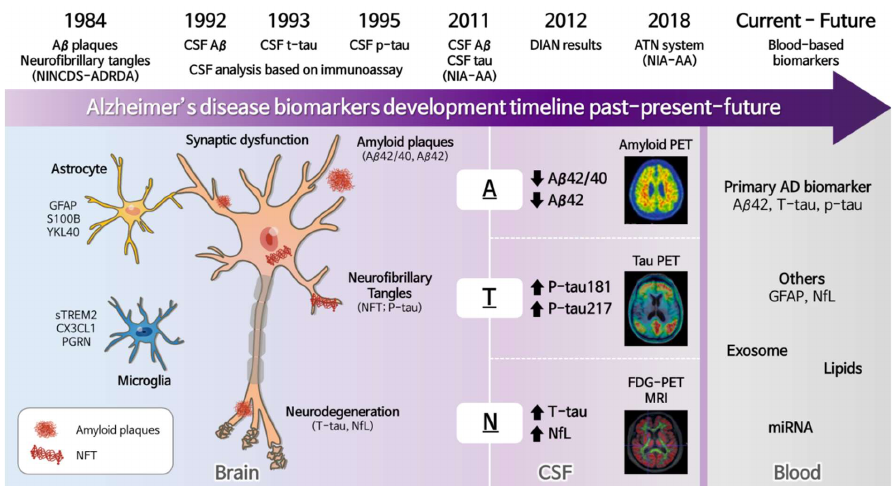
Figure 2. Schematic summarizes the milestones of Alzheimer’s disease biomarkers evolute during the past century. In 1984, the first release of criteria for the clinical diagnosis of AD (NINCDS-